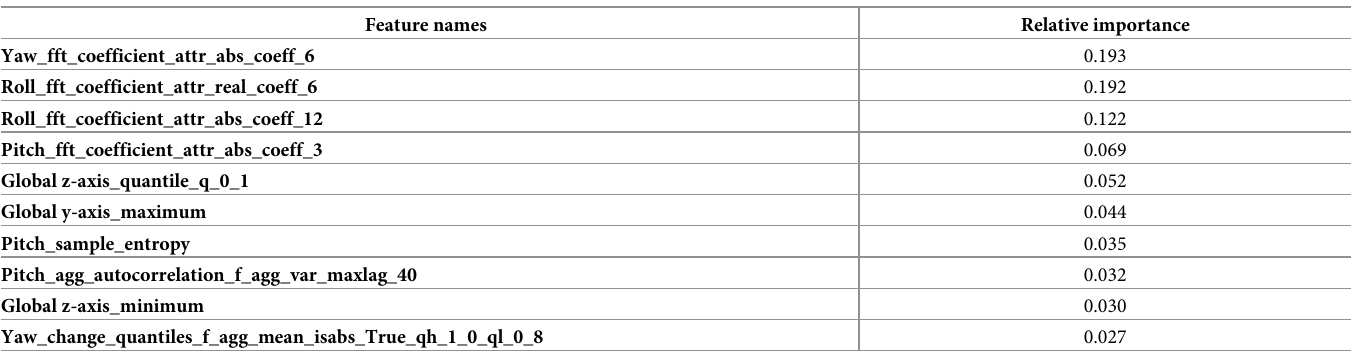
Table 2. Average relative importance of the top 10 features of the model using data of three gait